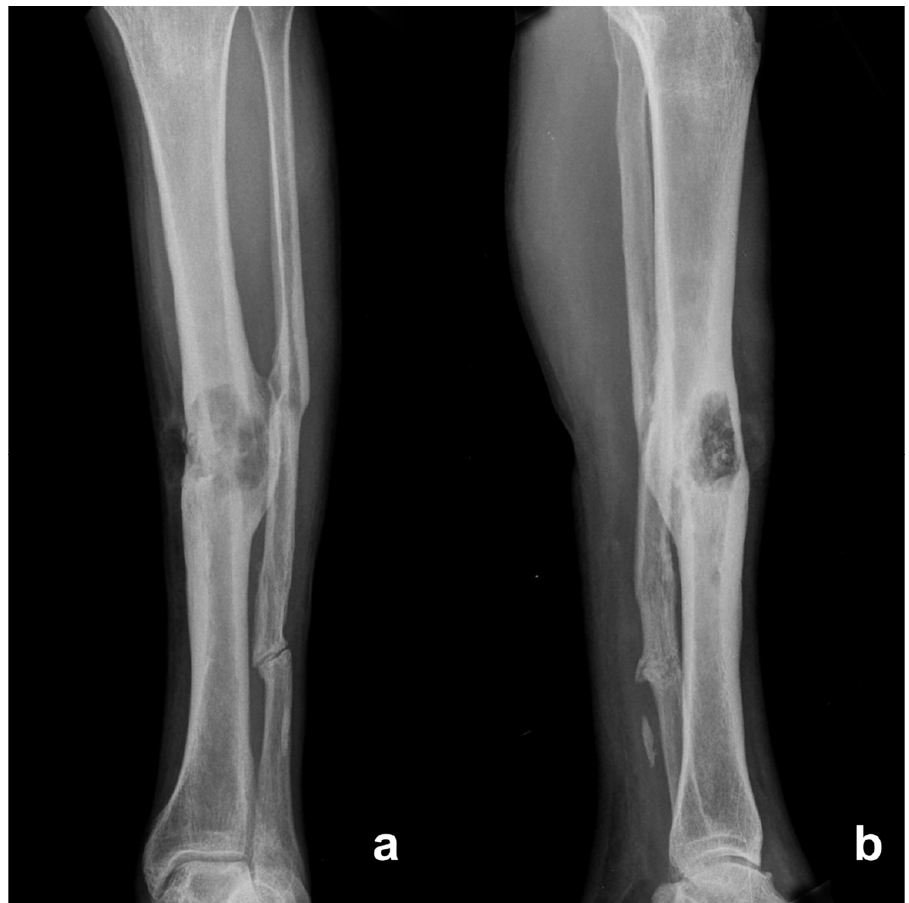
Figure 1. Antero-posterior ( a ) and lateral ( b ) radiographs show ill-defined radiolucent lesions, periosteal thickening disruption of the medial cortex compatible with chronic osteomyelitis and osteolysis of the middle third of the tibial shaft.